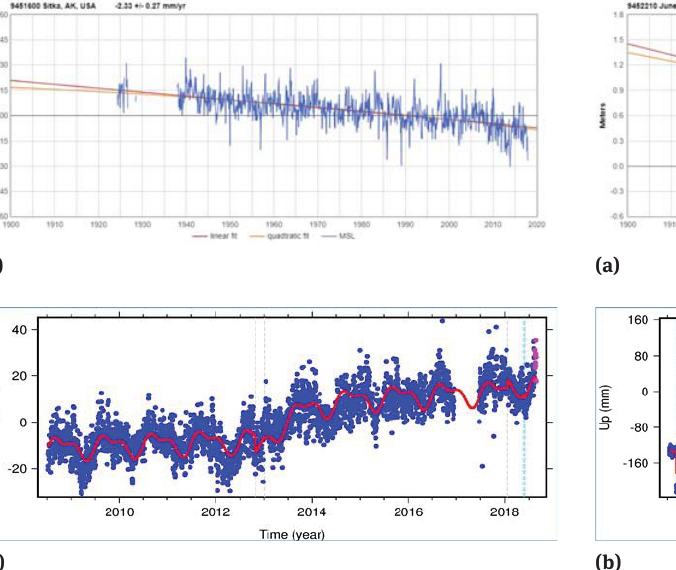
Figure 5: (a) MSL data for Juneau, AK, USA. Image reproduced mod- ified after [4]. (b) GNSS time series for JNU1. Image reproduced modified after